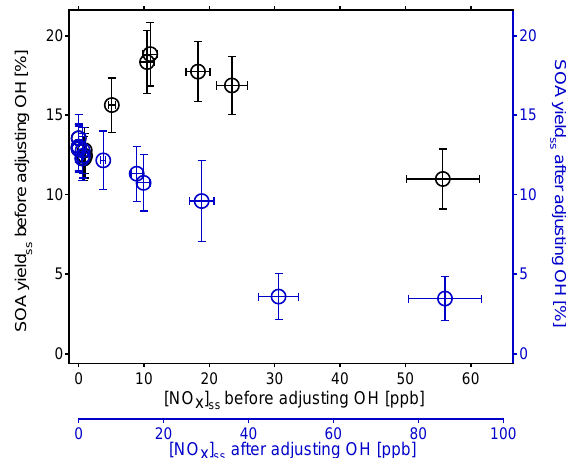
Figure 4. Comparison of [OH] before (black squares) and after (blue squares) adjusting OH concentration during steady state in NO x experiments. The errors in [OH] and [NO x ] were estimated to be ± 20 and ± 10% respectively.